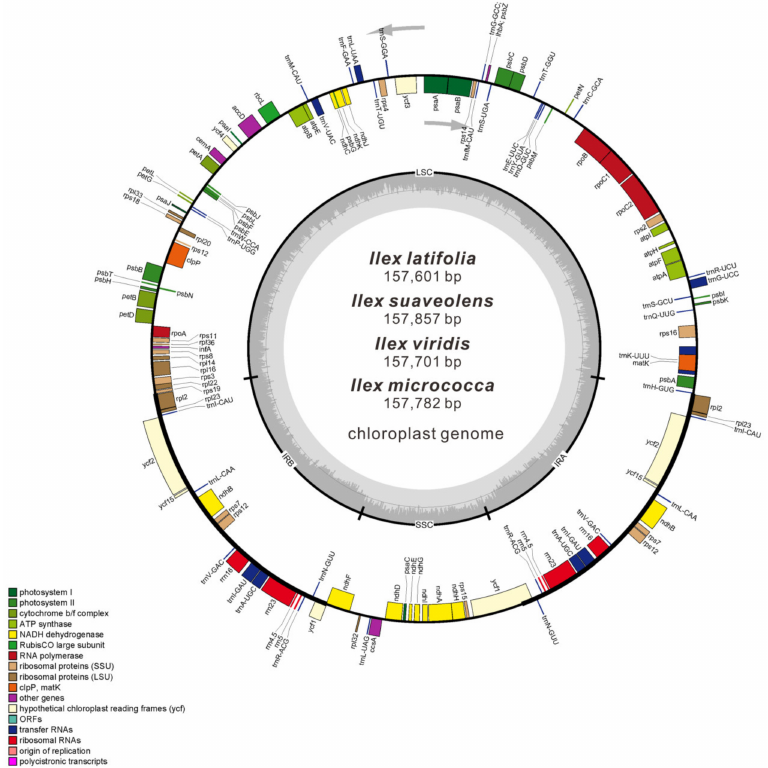
Figure 2. The plastome map of four Ilex species. The genes are shown by the gray arrowheads. Genes inside the circle indicate clockwise transcription, and those outsides are transcribed counterclockwise. The protein-encoding genes are marked in di ff erent colors. The GC content graphs are included as dark gray bars toward the center of the